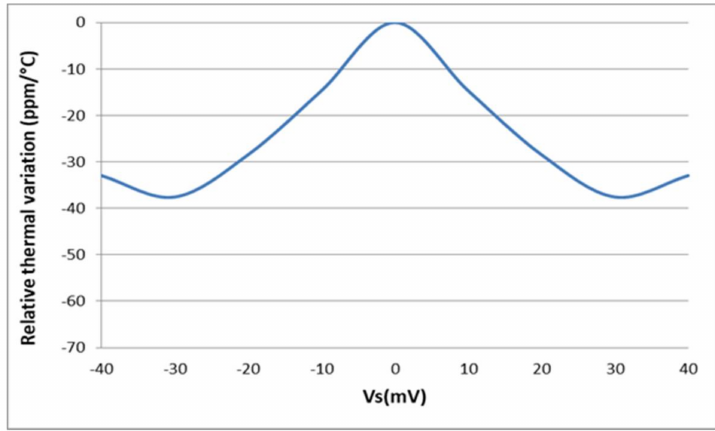
Figure 13. Simulated relative thermal variation of the sensor interface.